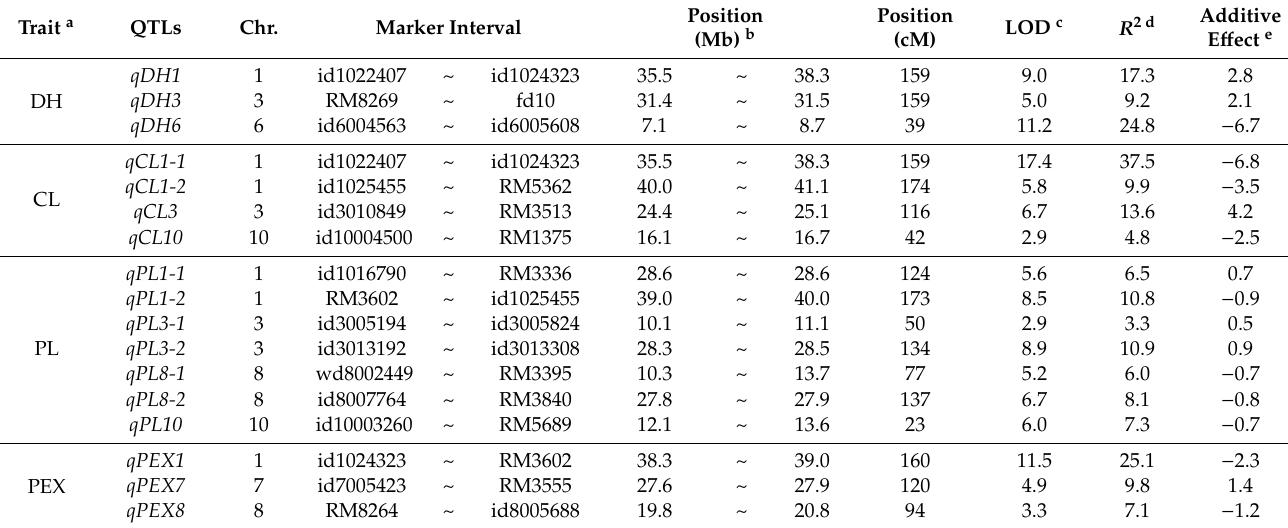
Table 6. QTL for other agronomic traits under cold-water-irrigated field determined by composite interval